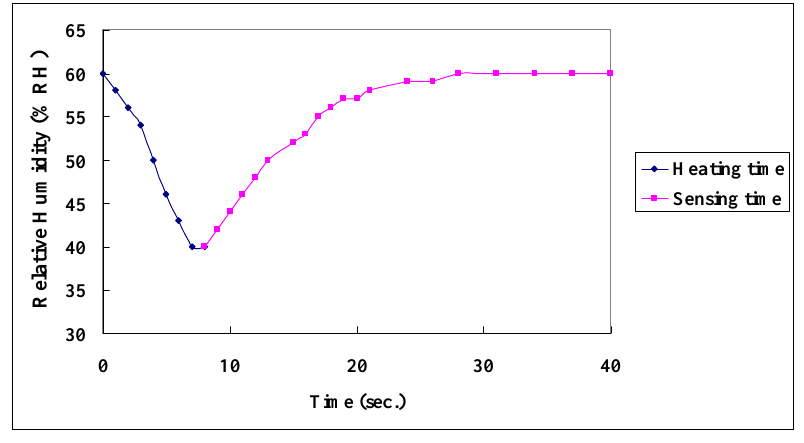
Figure 9. Response time of micro humidity sensor when used with a micro heater.